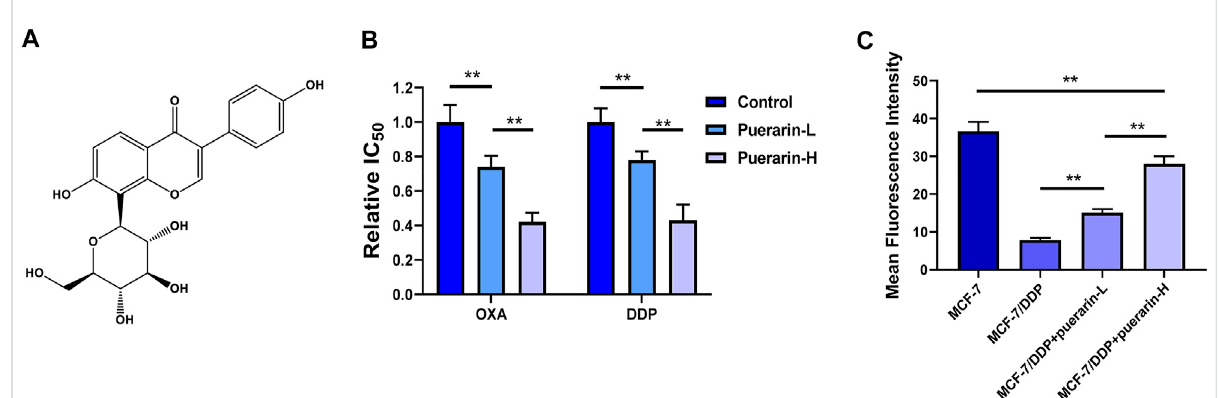
Puerarin reversed drug resistance of platinum-based anti-cancer drug. (A) The structural formulas of puerarin (B) The IC 50 values of OXA and DDPonMCF-7weredetected.Thecancercellsweretreatedwithdifferentconcentrationsofpuerarin(Control:DMSO,puerarin-L:20 μ